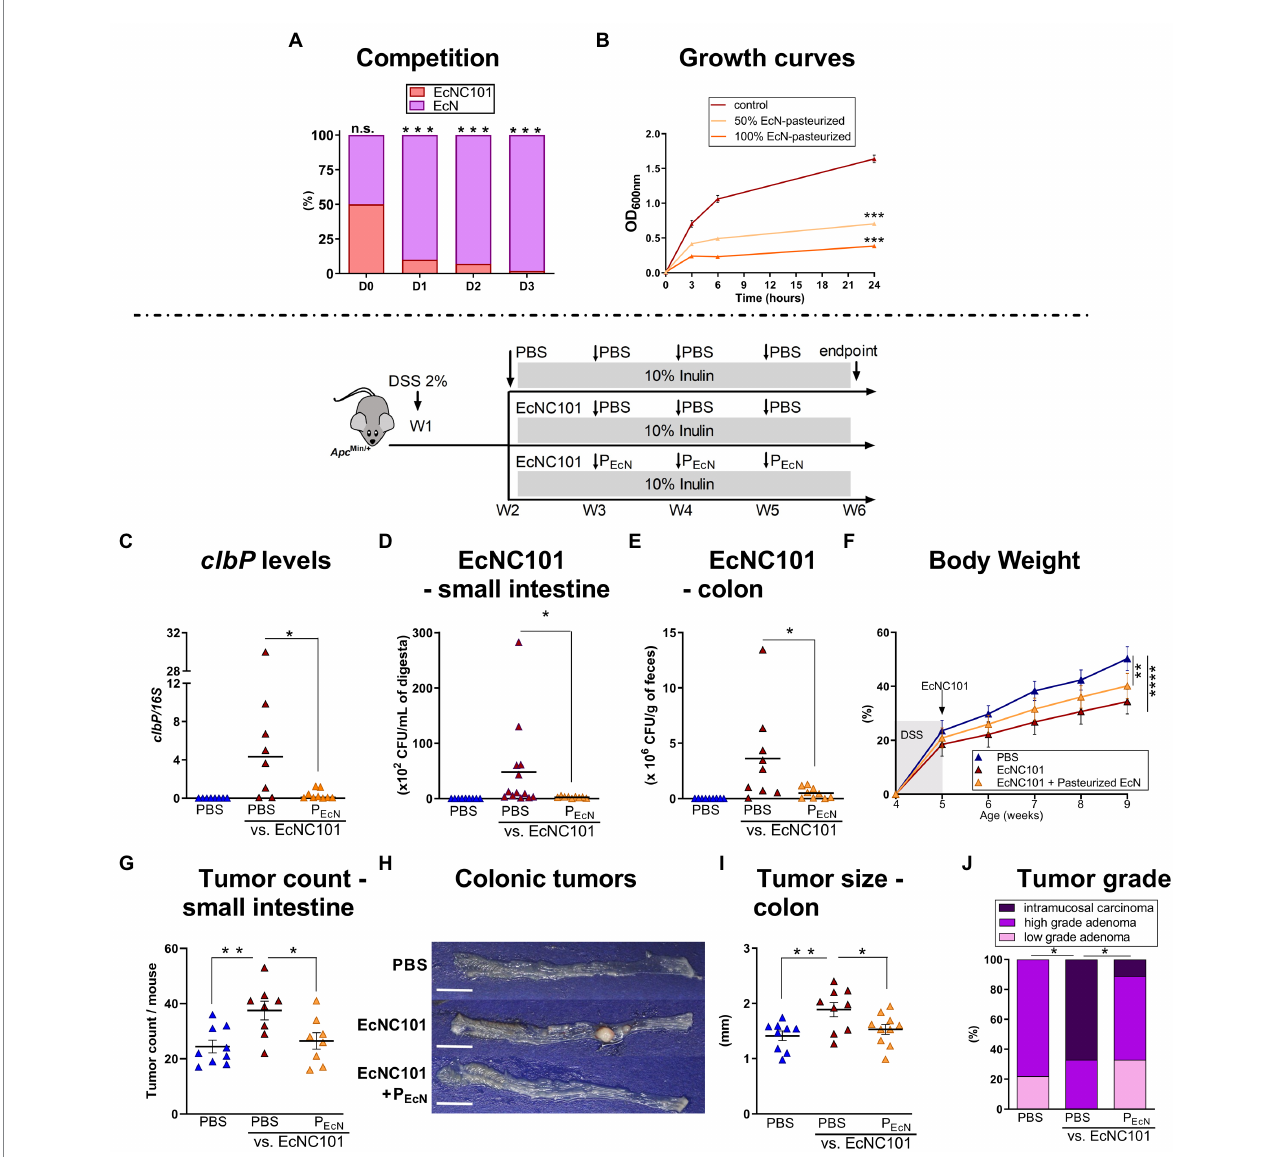
FIGURE 4 Effect of pasteurized E. coli Nissle on EcNC101 growth, tumorigenesis and tumor development in inulin-fed Apc Min/+ mice. (A) Competition assay between EcNC101 and EcN for three days (Fisher’s Test). (B) OD 600 of EcNC101 grown in LB supplemented with 50 and 100% pasteurized EcN (repeated-measure ANOVA). (C–I) Mice were fed a diet supplemented with 10% inulin and were gavaged with PBS or 10 8 CFU of EcNC101 at W2, followed by an oral gavage with PBS or 10 8 CFUs of pasteurized EcN (P EcN ) at W3, 4 and 5. (C–E) EcNC101 colonization assessed by (C) PCR quantification of clbP gene level normalized to 16S rRNA gene levels; and by CFUs in the (D) small intestine and (E) in the colon. (F) Body weight (mean ± SEM; between PBS and EcNC101 mice, repeated-measure ANOVA). (G) Tumor count in the small intestine. (H) Representative images of colonic tumors (left side: cecum, right side: rectum), scale bar = 1 cm. (I) Tumor size in the colon. (J) Colonic tumor grades (Chi-square Test). n.s. non-significant; * p < 0.05, ** p < 0.01¸*** p < 0.001, **** p < 0.0001. ANOVA, N = 9–14 per